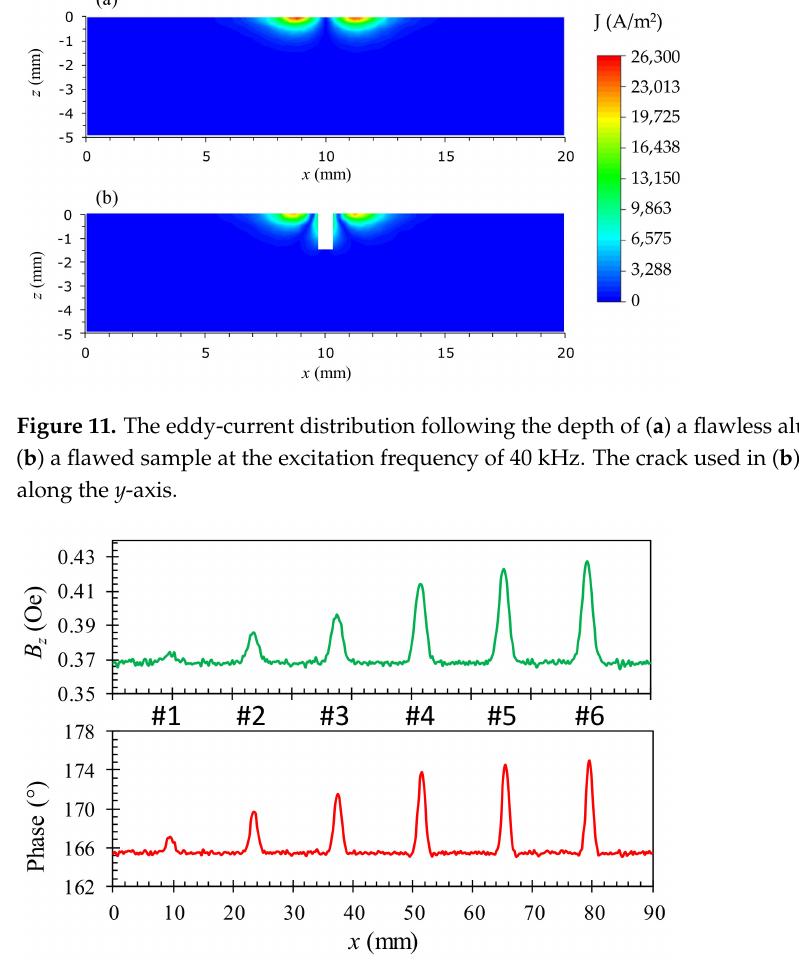
Figure 12. The amplitude and phase signals of the vertical component of secondary field when scanning over cracks with different depths of 0.1, 0.3, 0.5, 1.0, 1.5, and 1.8 mm with the 40 kHz excitation frequency. The lift-off distance is 0.2